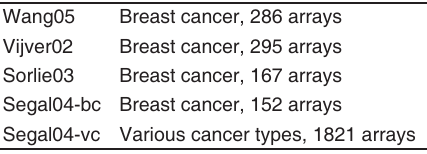
Figure 2. Compendia of microarray data. Microarray datasets can be grouped into compendia at various levels of underlying phenotypic diversity. The pie-chart indicates datasets from various origins, sizes, and cancer types, and the compendia are indicated by the outer rings. The ’Inter1’ training-validation configuration is depicted in this figure ([4] as training, and [3] as validation). This is one of the six configurations employed (See Table 1 for details).